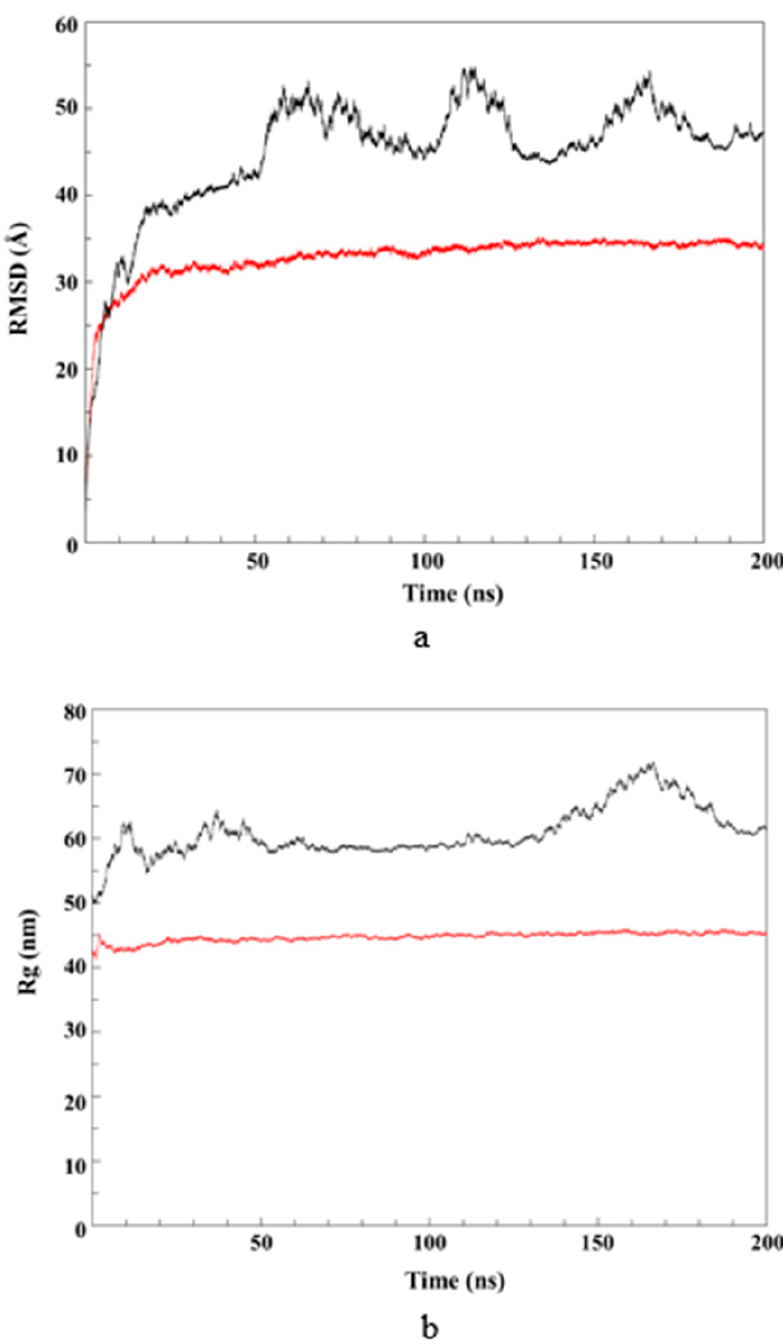
Figure 8. RMSD ( a ) and R g ( b ) of assemblies in the SLNs without (shown in red) and with RMO (shown in black).